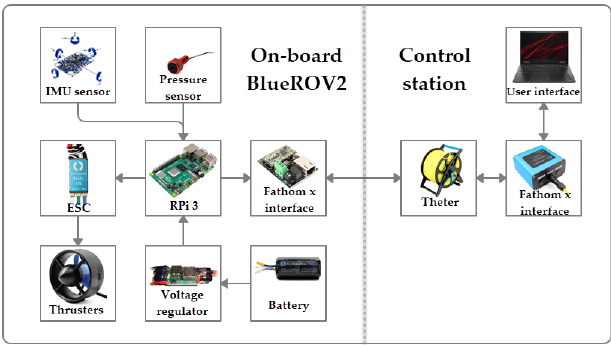
Figure 5. BlueROV2 hardware configuration.